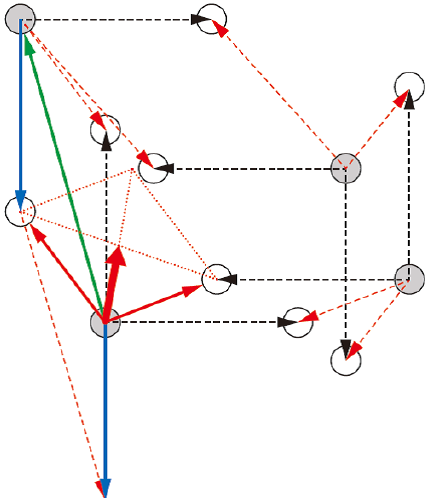
Fig. 10. Pheromone agents attract the target ant